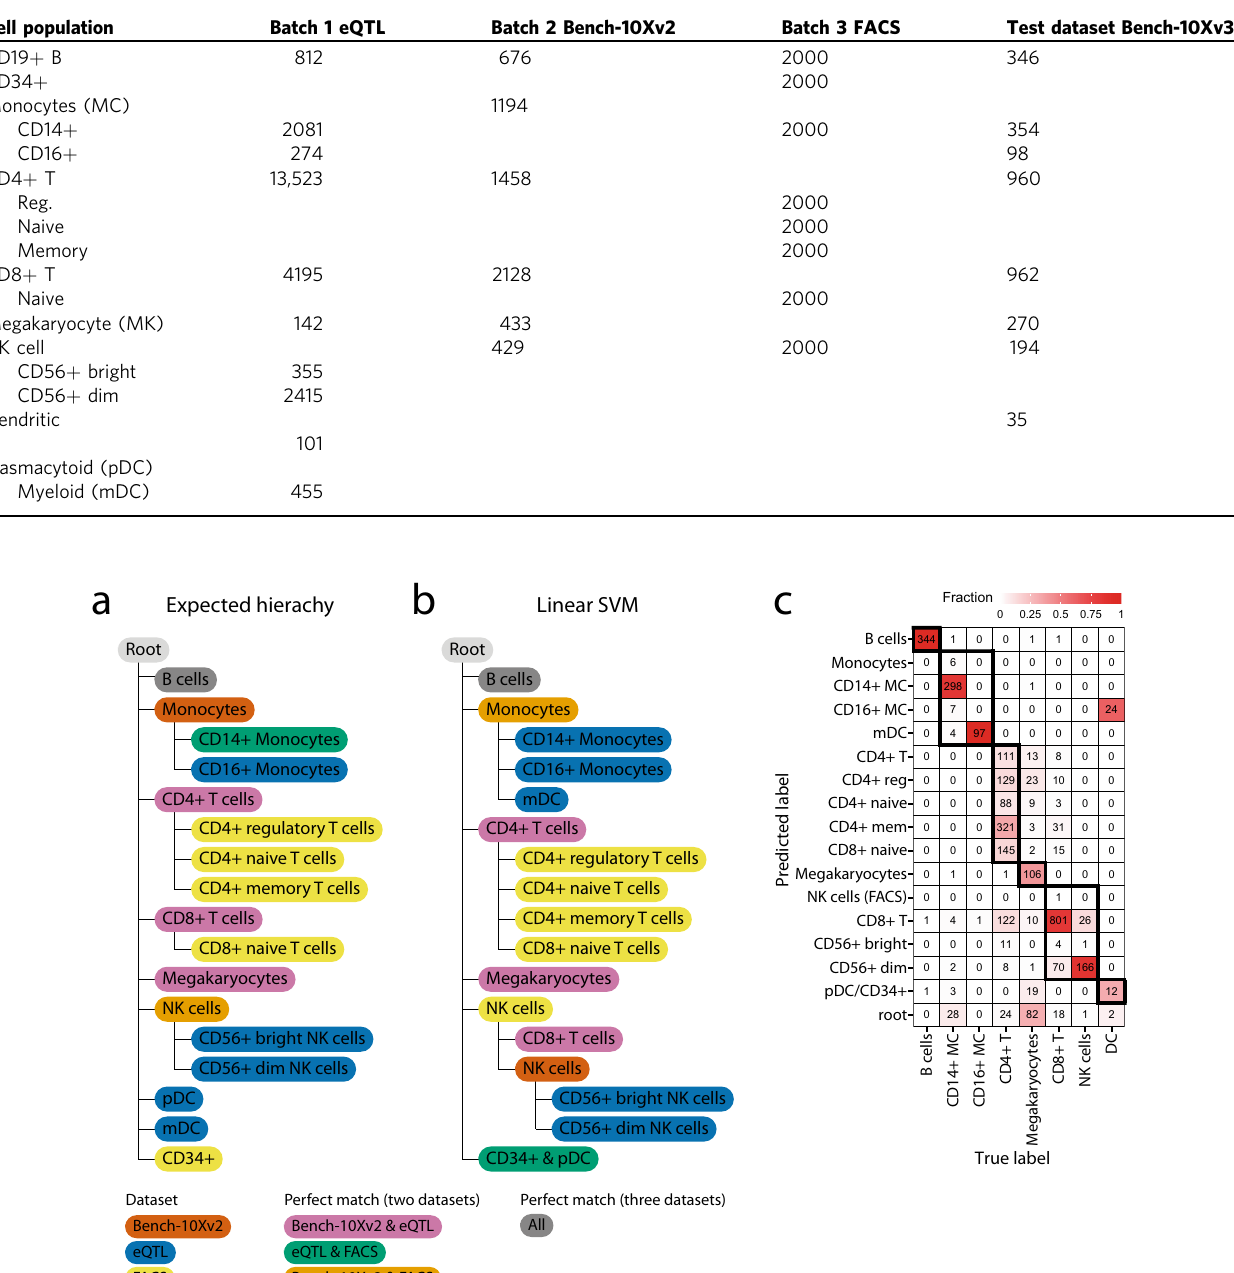
Table 1 Number of cells per cell population in the different training datasets (batches) and test dataset. Subpopulations are indicated using an indent.